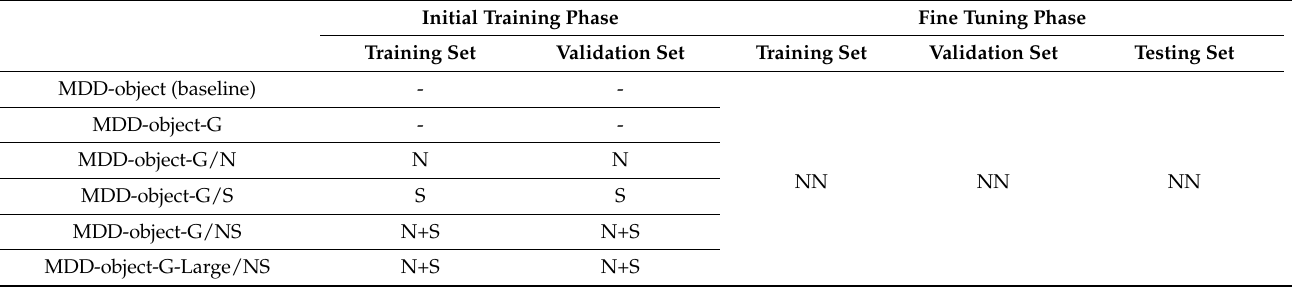
Table 7. Speech type for the proposed models. N: native speech; S: synthesized speech; NN: non- native